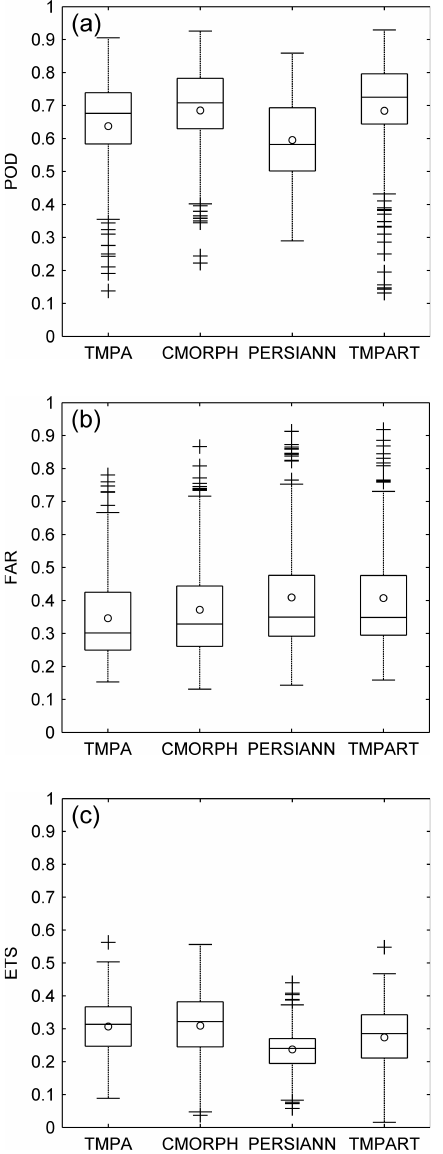
Fig. 4. Box plots of contingency table statistics for (a) POD, (b) FAR and (c) ETS. The circle represents the mean value. Each box ranges from the lower quartile (25th) to upper quartile (75th). The median is presented by the middle line in the box. The whiskers extend out to largest and smallest values within 1.5 times the in- terquartile range (difference between the 75th and 25th percentiles). The plus represents the points beyond the